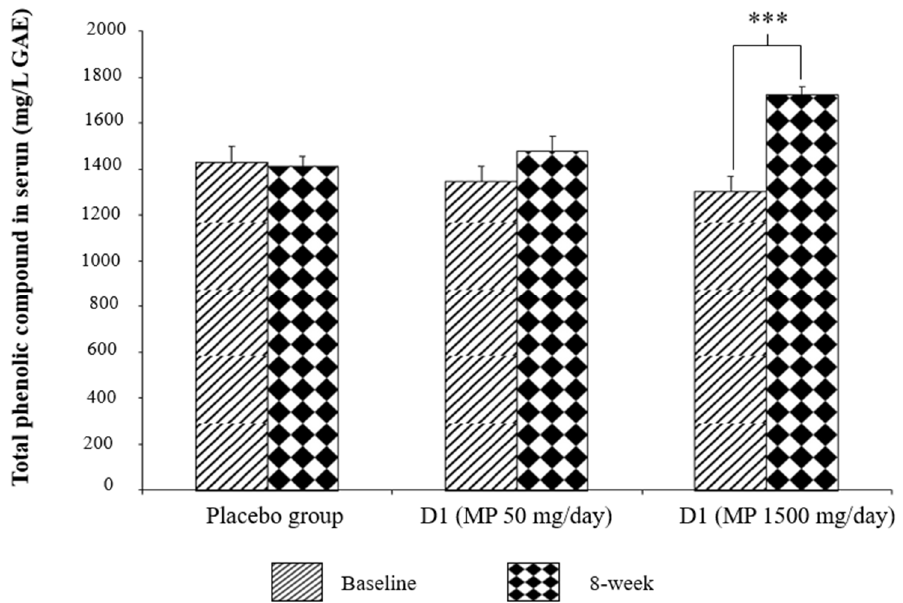
Figure 4. Serum level of the total phenolic compounds in the subjects who consumed the assigned substances at the end of the 8-week study period. (N = 15/group). Values are expressed as mean ± SD. Data are analyzed using ANOVA. *** p -value < 0.001; compared to the placebo group .